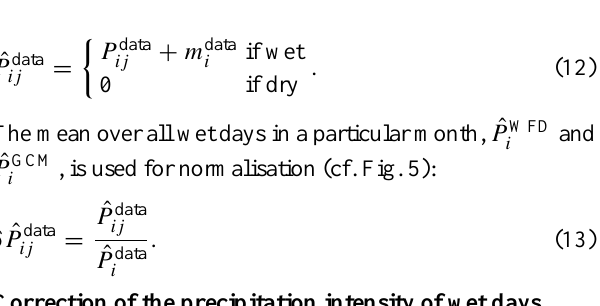
Fig. 5. Normalised cumulative sums of daily observational and simulated April precipitation values during the reference period for the example grid cell. Dry days and months are omitted. For all wet days of the reference period uncorrected values before and after the redistribution of drizzle (left panel), and normalised values (right panel) are shown. The vertical lines refer to related mean (solid) and mean+standard deviation (dashed). Horizontal bars are for comparison of the standard